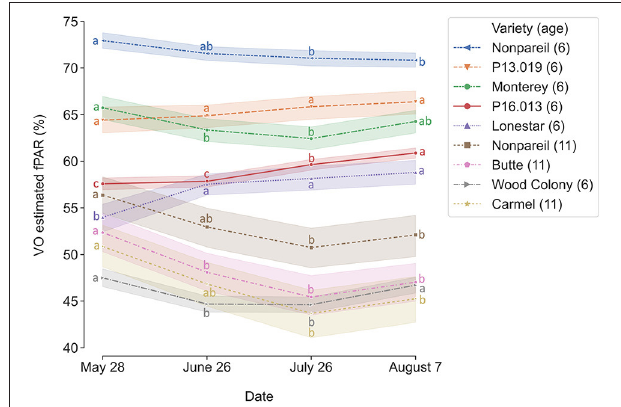
FIGURE 3 | Changes of canopy fractional PAR (fPAR) estimated by Virtual Orchard (VO) over the growing season in 2019. Different letters refer to a statistically significant difference over the season for each variety and age using Tukey honestly significant difference (HSD) test ( p < 0.05). The size of the confidence intervals of 95% was drawn. Means ± standard deviations (SD) of the yield (lb acre − 1 ) for each group were 2000.76 ± 385.38, nan (no data available), 2121.86 ± 572.39, 1013.60 ± 395.84, 1558.49 ± 520.28, 1055.28 ± 386.69, 988.85 ± 463.91, 1436.00 ± 250.07, nan, respectively, from the top to the bottom of the